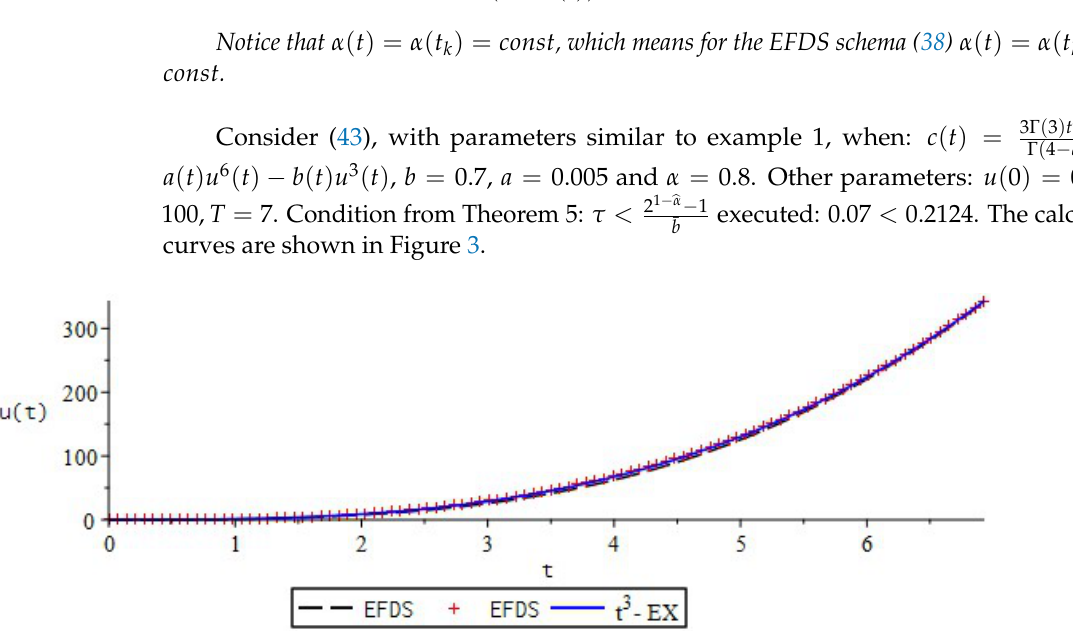
Figure 3. Exact solution EX: u ( t ) = t 3 and numerical solutions of the fractional Riccati equation with constant coefficients and α = 0.8, taking into account the fulfillment of the